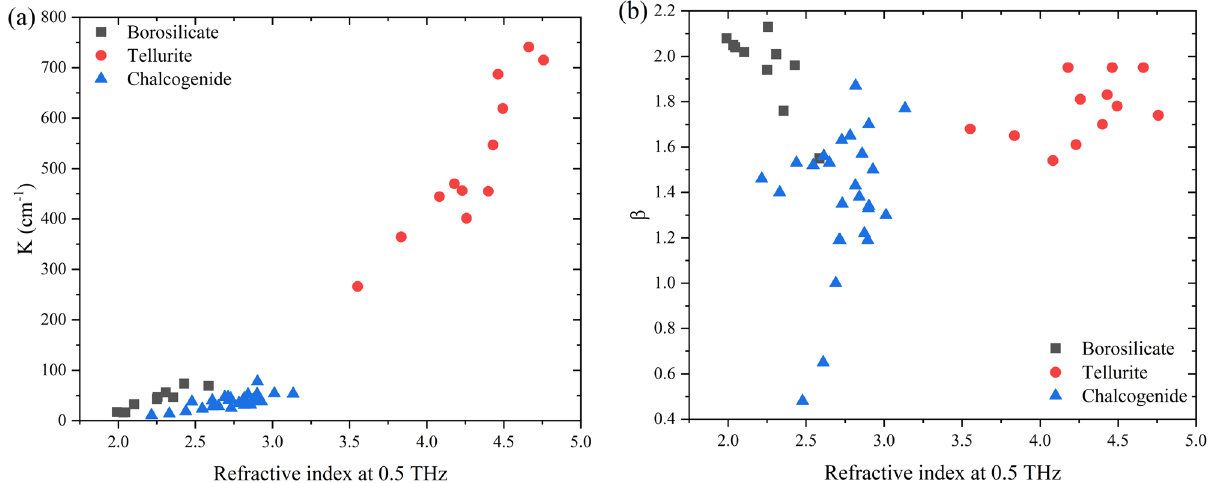
Figure 6. Relationship between ( a ) K and ( b ) β and 0.5 THz refractive